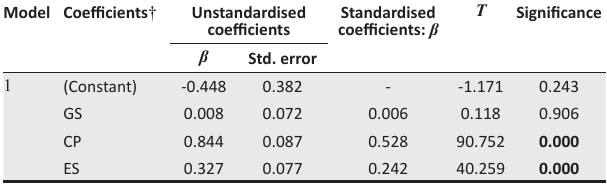
TABLE 4: Regression analysis of environment context variables.